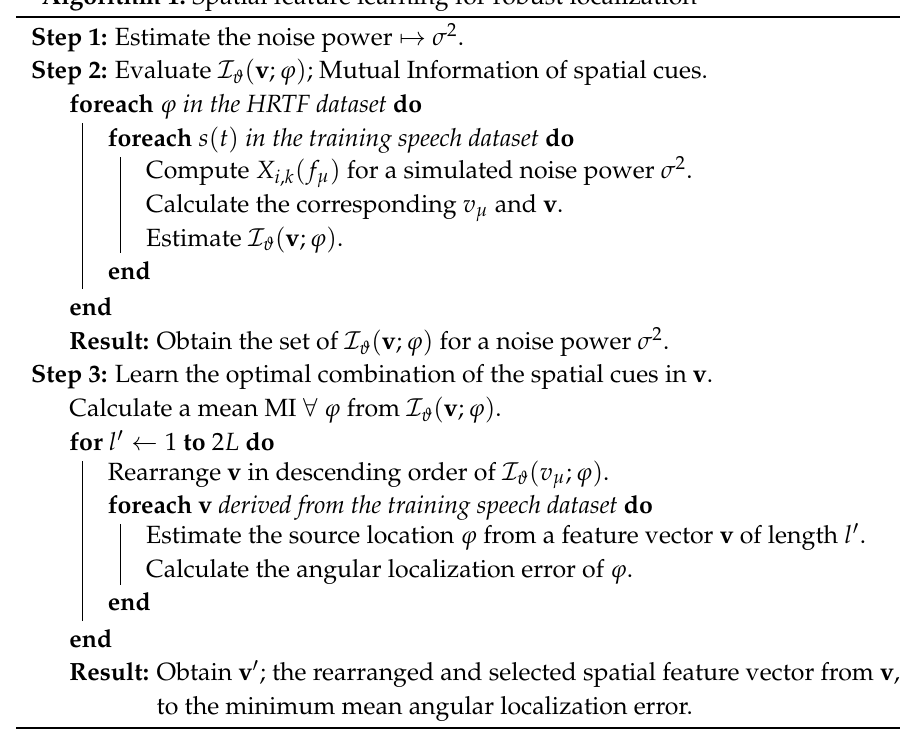
Algorithm 1: Spatial feature learning for robust